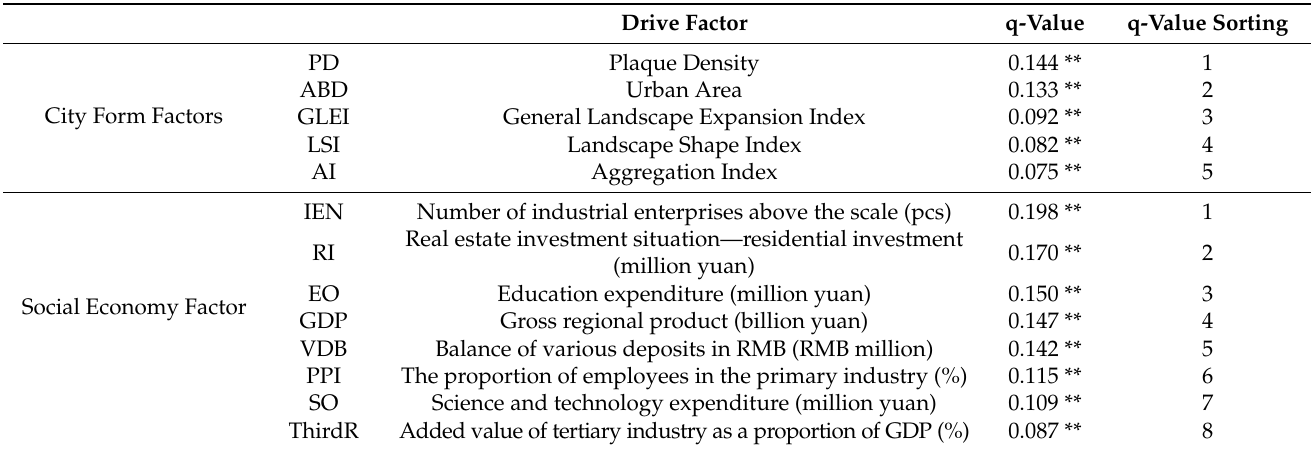
Table 3. Results of detecting driving